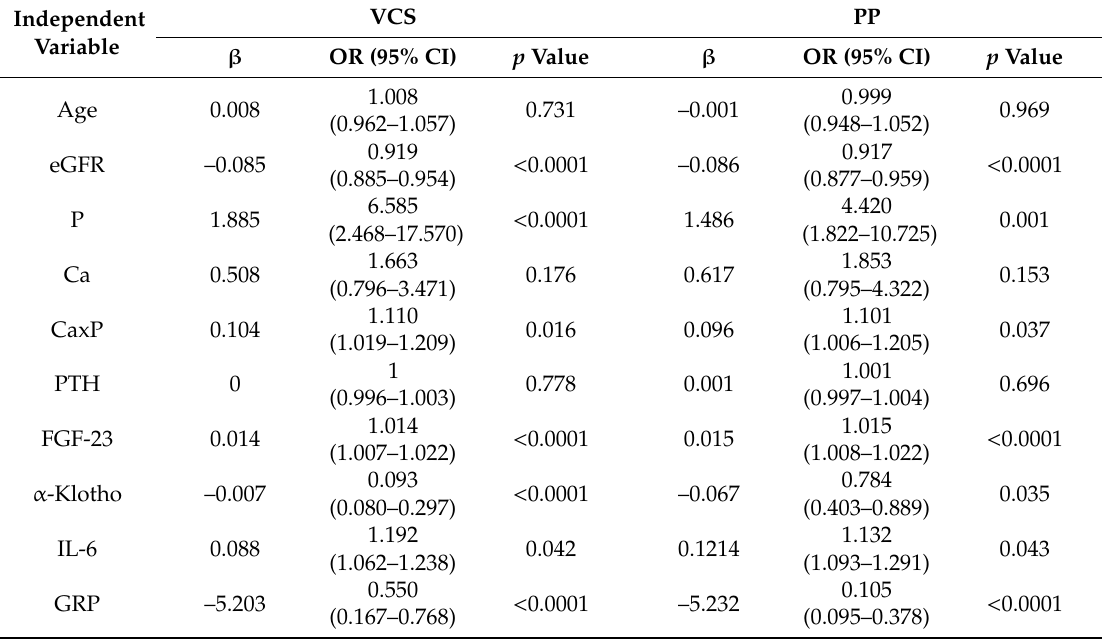
Table 4. Factors associated with the vascular calcification score (VCS) and pulse pressure (PP). Independent